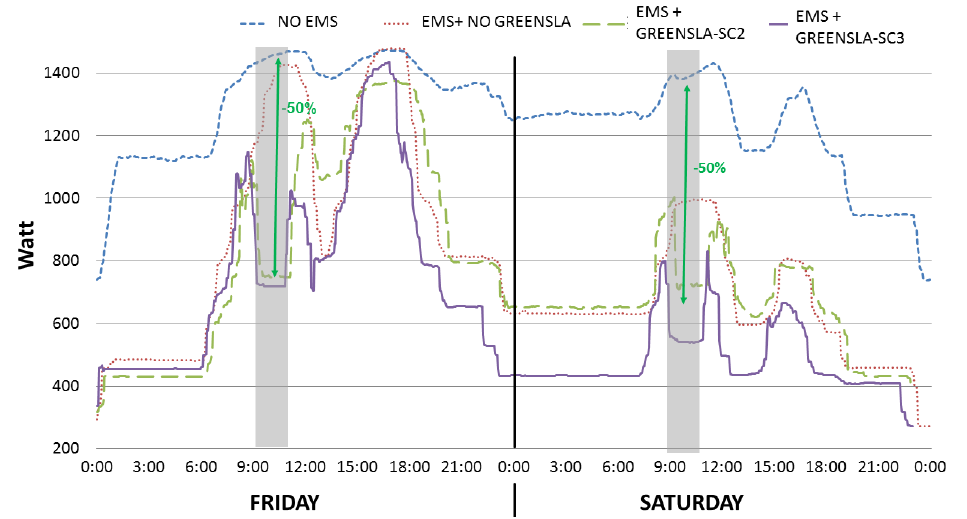
Figure 7. Power consumption (Watt) of the tested “Demand-Response without Federation Scenario”.